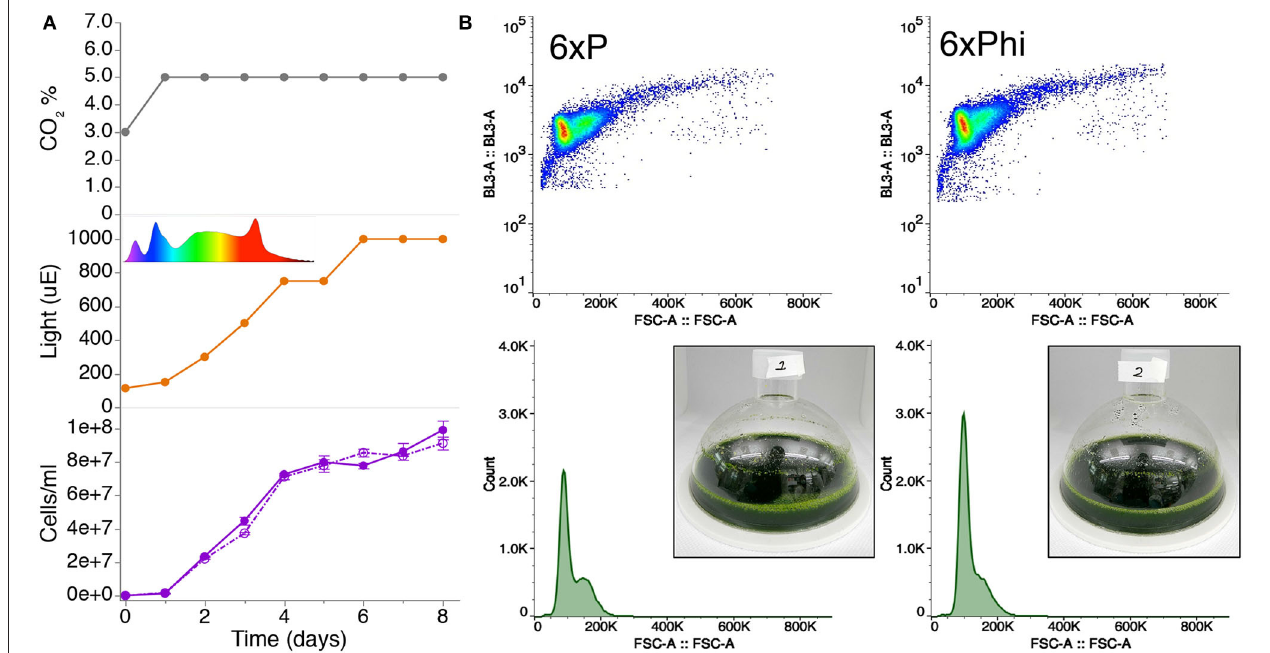
FIGURE 2 | Buffered phosphite solutions can be used in algal high-cell density medium concepts to replace phosphate. (A) Growth of strain UPN22 was tracked in cultivations in 100ml of 6XP (solid line) or 6XPhi (dashed line) media in CellDeg HD100 cultivators, following the CO 2 and light regime indicated. The spectrum of the Valoya daylight lamp is shown. Cell densities were recorded daily. Values represent mean ( ± standard error mean) of three technical replicates per reactor and sampling point. (B) Forward and backscatter plots from flow cytometry of samples from day 6 of each culture with photographs of the dense green culture in either